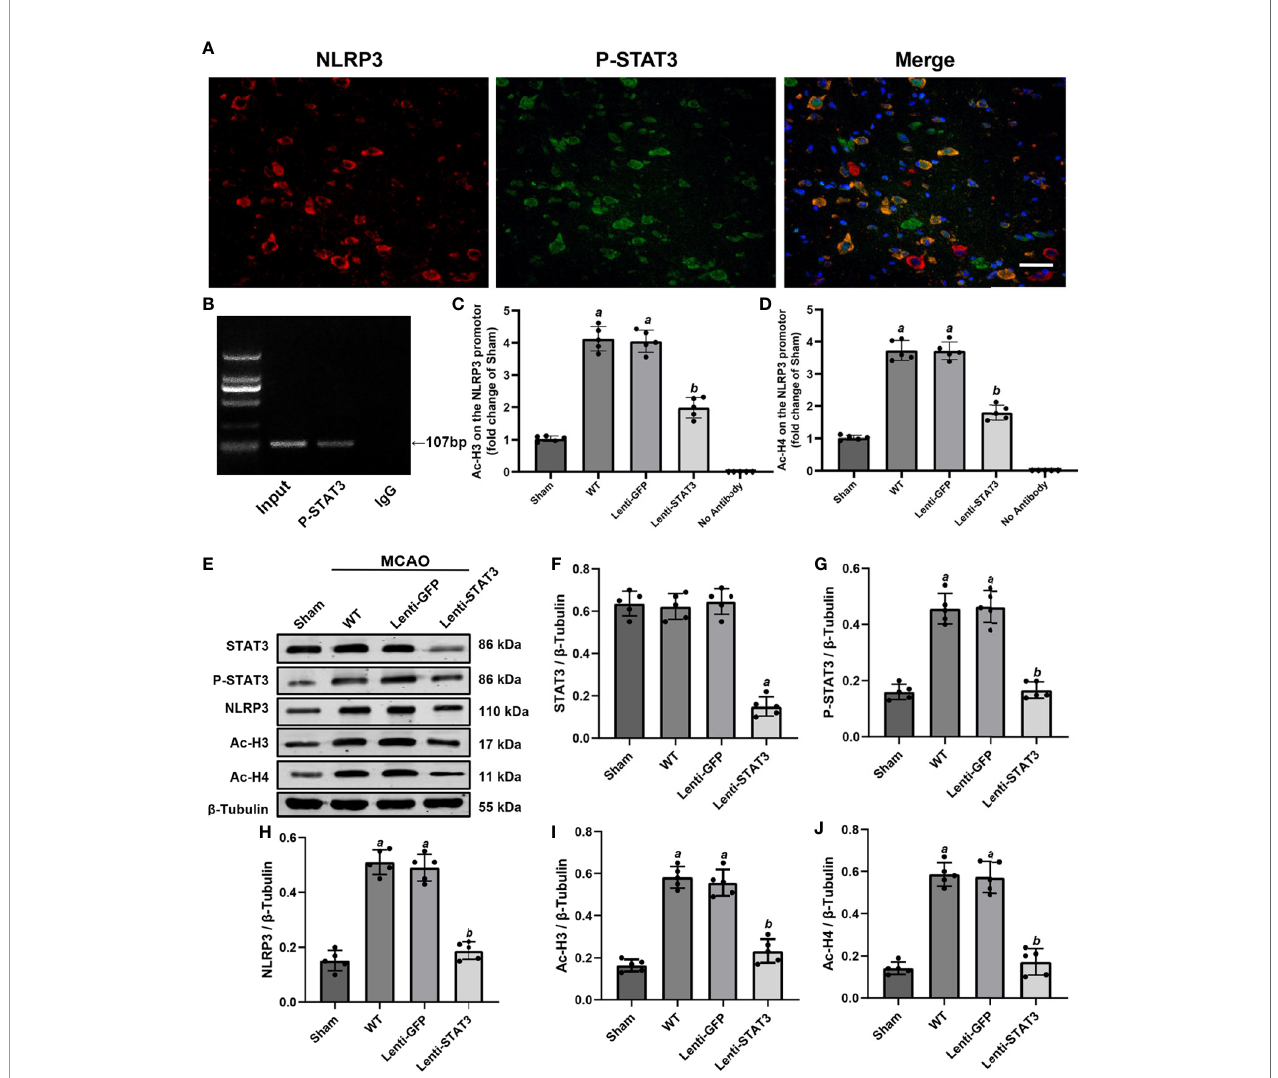
FIGURE 9 | Local STAT3 de fi ciency decreased histone H3 and H4 acetylation and NLRP3 expression. (A) Representative immunostaining of NLRP3 and P-STAT3 in the penumbra of the ischemic cortex 3 days after MCAO. (B) ChIP assay indicating that P-STAT3 bound to the NLRP3 promotor. (C, D) ChIP-qPCR assays showing that Ac-H3 and Ac-H4 on the NLRP3 promotor were decreased by local STAT3 de fi ciency. (E) Representative western blots showing that STAT3 knockout restrained the expression of P-STAT3, NLRP3, and global Ac-H3 and Ac-H4 in the peri-ischemic region 3 days after MCAO. (F – J) Quanti fi cation of STAT3, P- STAT3, NLRP3, and global Ac-H3 and Ac-H4 levels in the ischemic penumbra. Means ± SD. n = 5/group. a P < 0.001 versus sham; b P < 0.05 versus lenti-GFP. Scale bar: 50